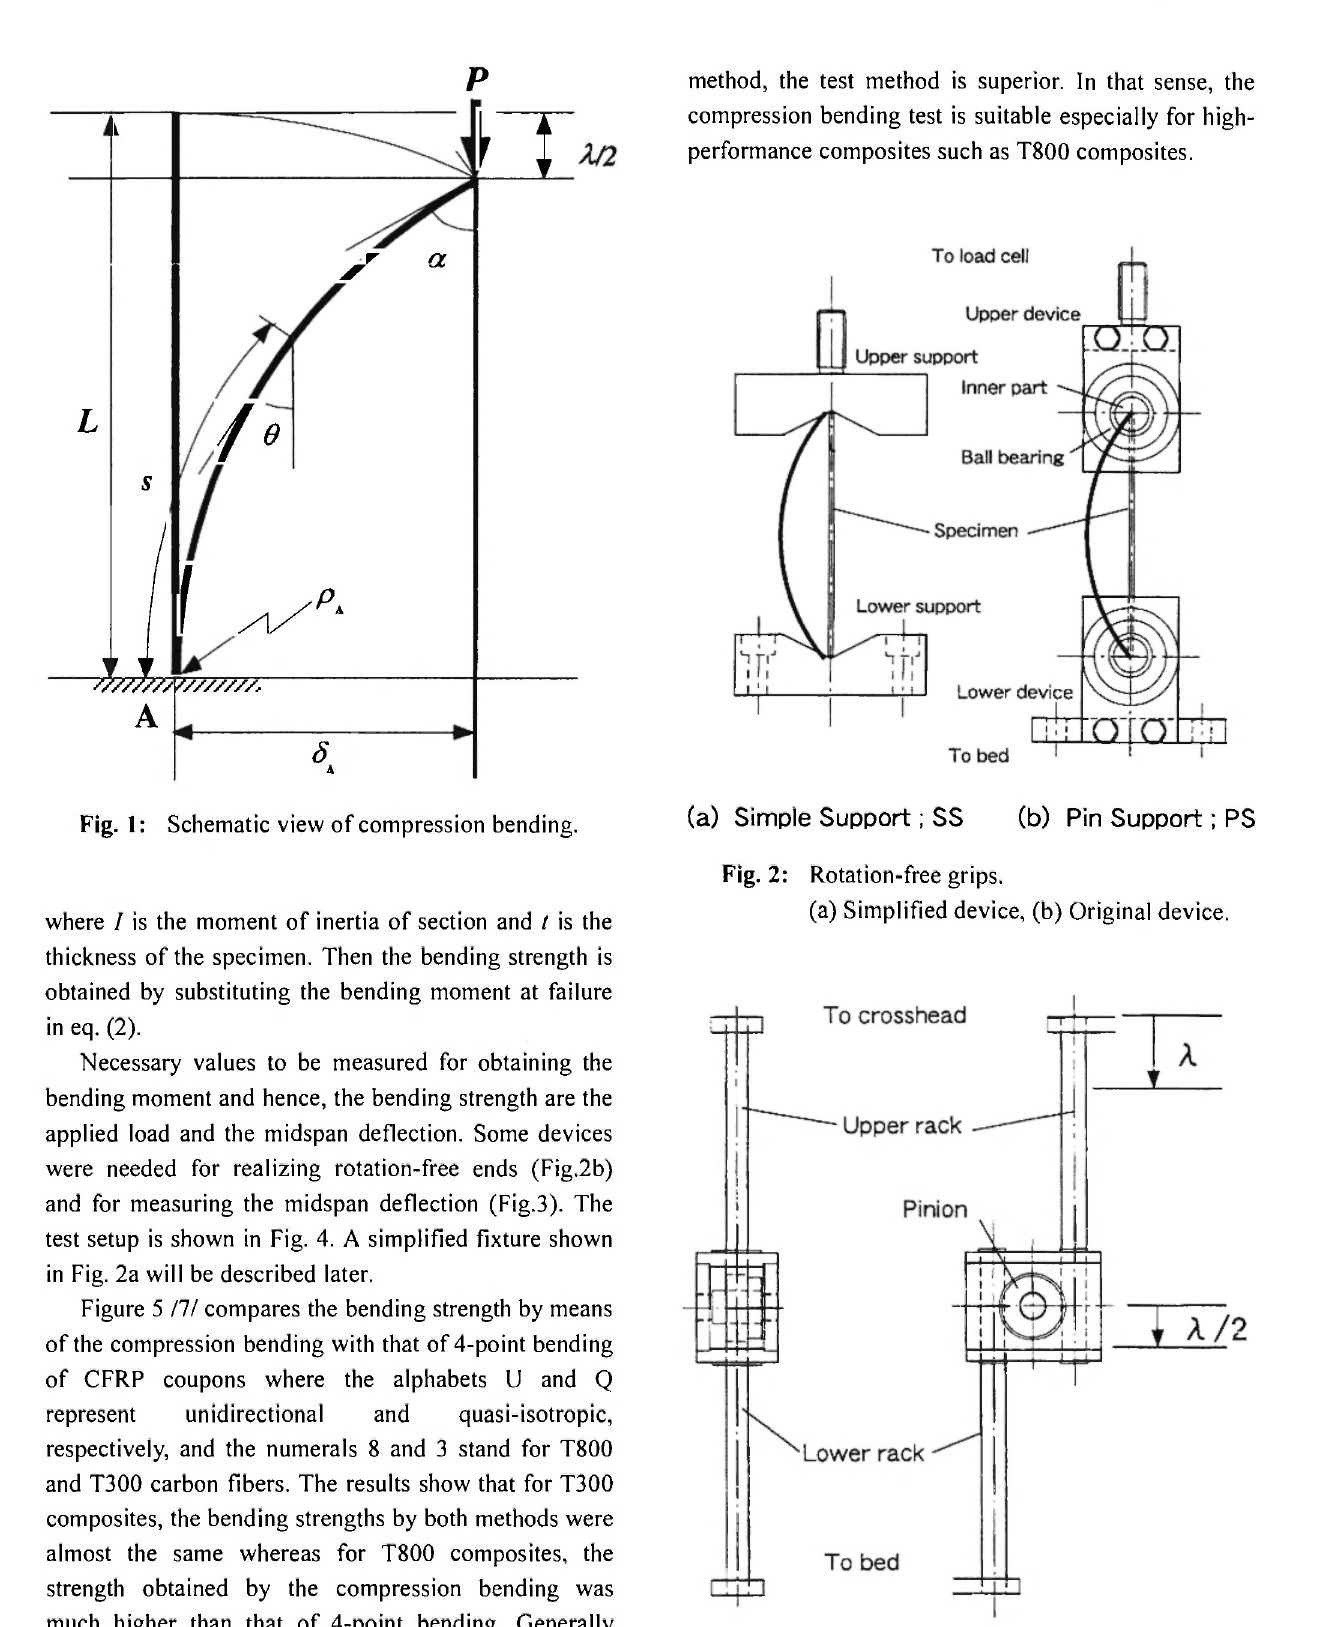
Fig. 1 : Schematic view of compression bending. where / is the moment of inertia of section and t is the thickness of the specimen. Then the bending strength is obtained by substituting the bending moment at failure in eq. (2).